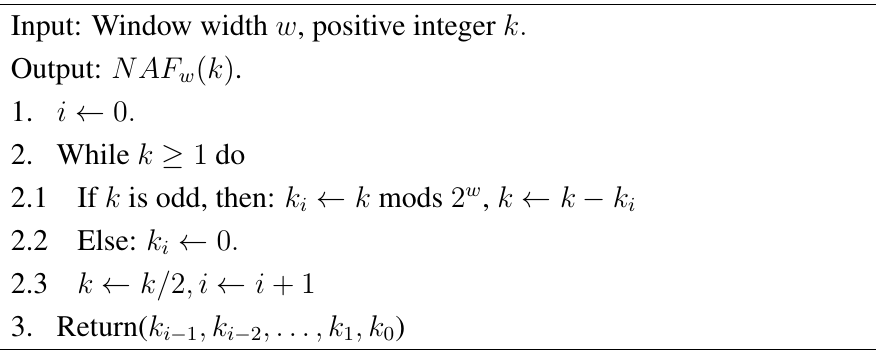
Algorithm 2. Computing the width- w NAF of a positive